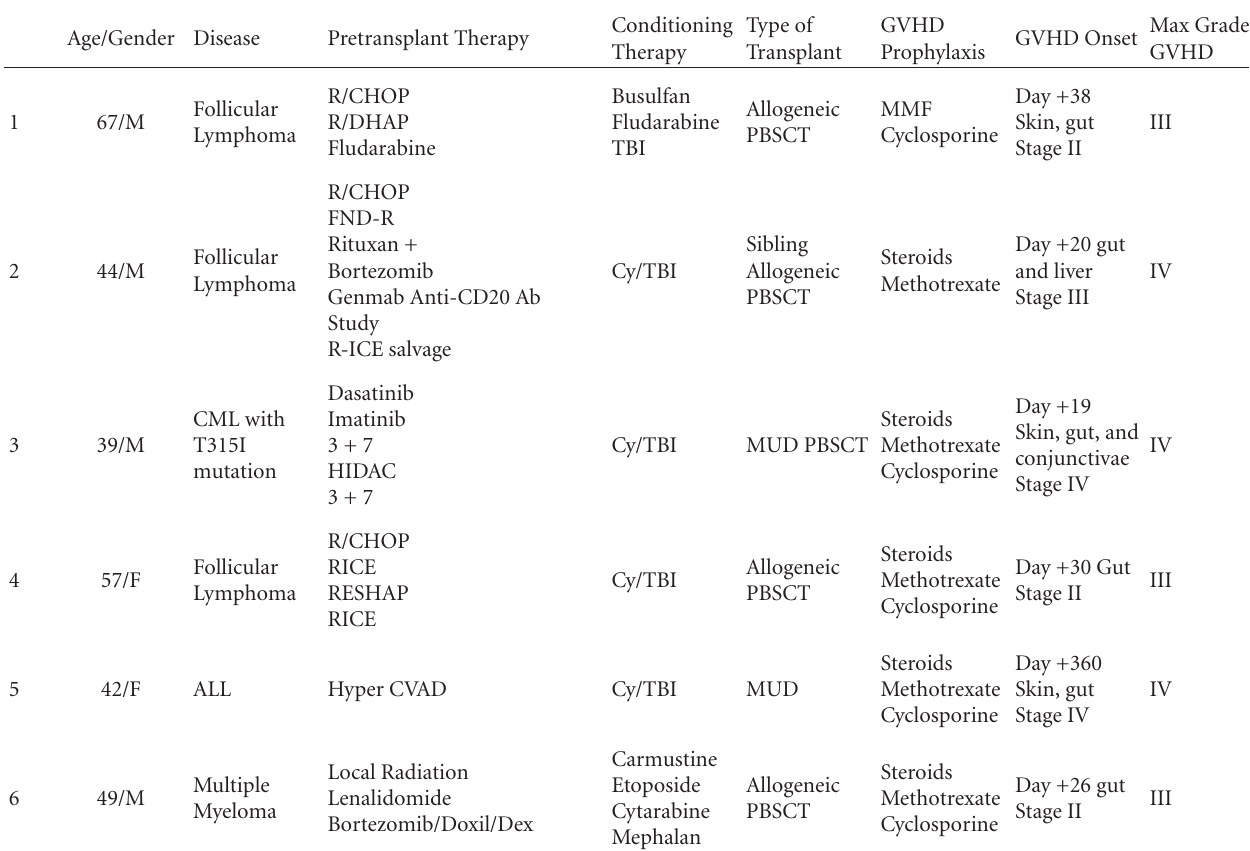
Table 1: Patient Demographics. Cy/TBI: Cyclophosphamide/Total Body Irradiation, PBSCT: Peripheral Blood Stem Cell Transplant, MUD: Matched unrelated donor, CML: Chronic Myeloid Leukemia, ALL: Acute Lymphocytic Leukemia, CML: Chronic Myeloid Leukemia, M: male, F: female.